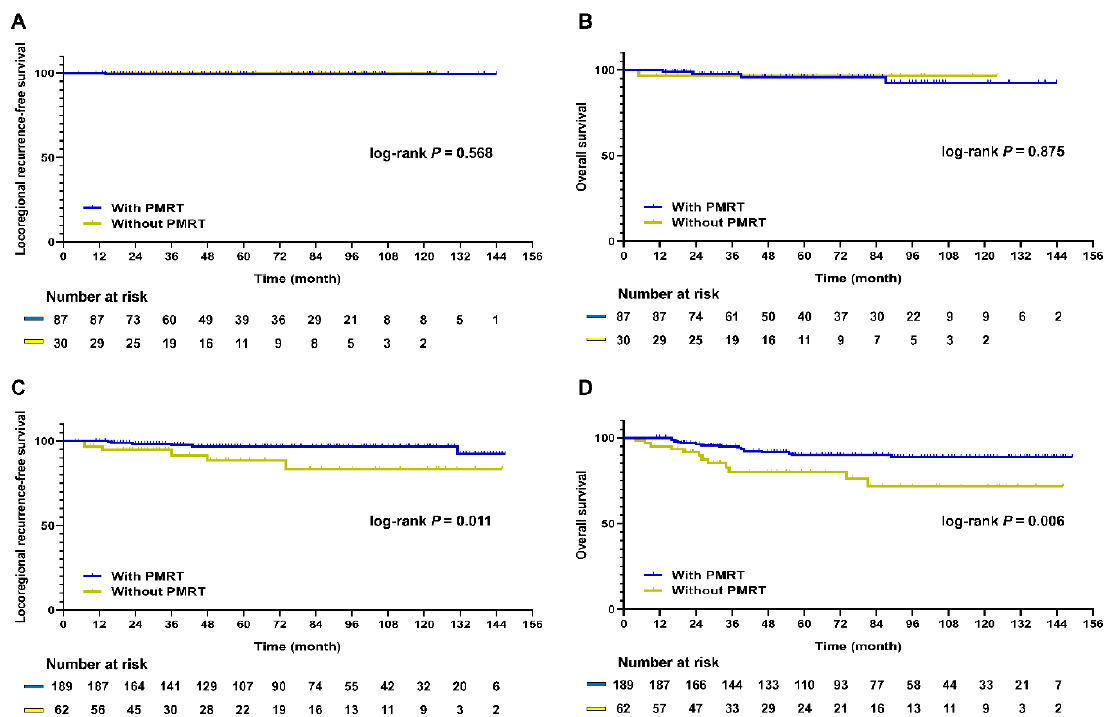
Figure 3. Kaplan–Meier survival curve of LRRFS and OS according to PMRT status in 1:3 PSM patients. ( A ) LRRFS in patients with 0.7 < NRI ≤ 1 ( p = 0.568); ( B ) OS in patients with 0.7 < NRI ≤ 1 ( p = 0.875); ( C ) LRRFS in patients with NRI < 0.7 ( p = 0.011); ( D ) OS in patients with NRI < 0.7 ( p = 0.006). LRRFS, locoregional recurrence-free survival; OS, overall survival; PMRT, post-mastectomy radiotherapy; NRI, neoadjuvant response index; PSM, propensity score matching.